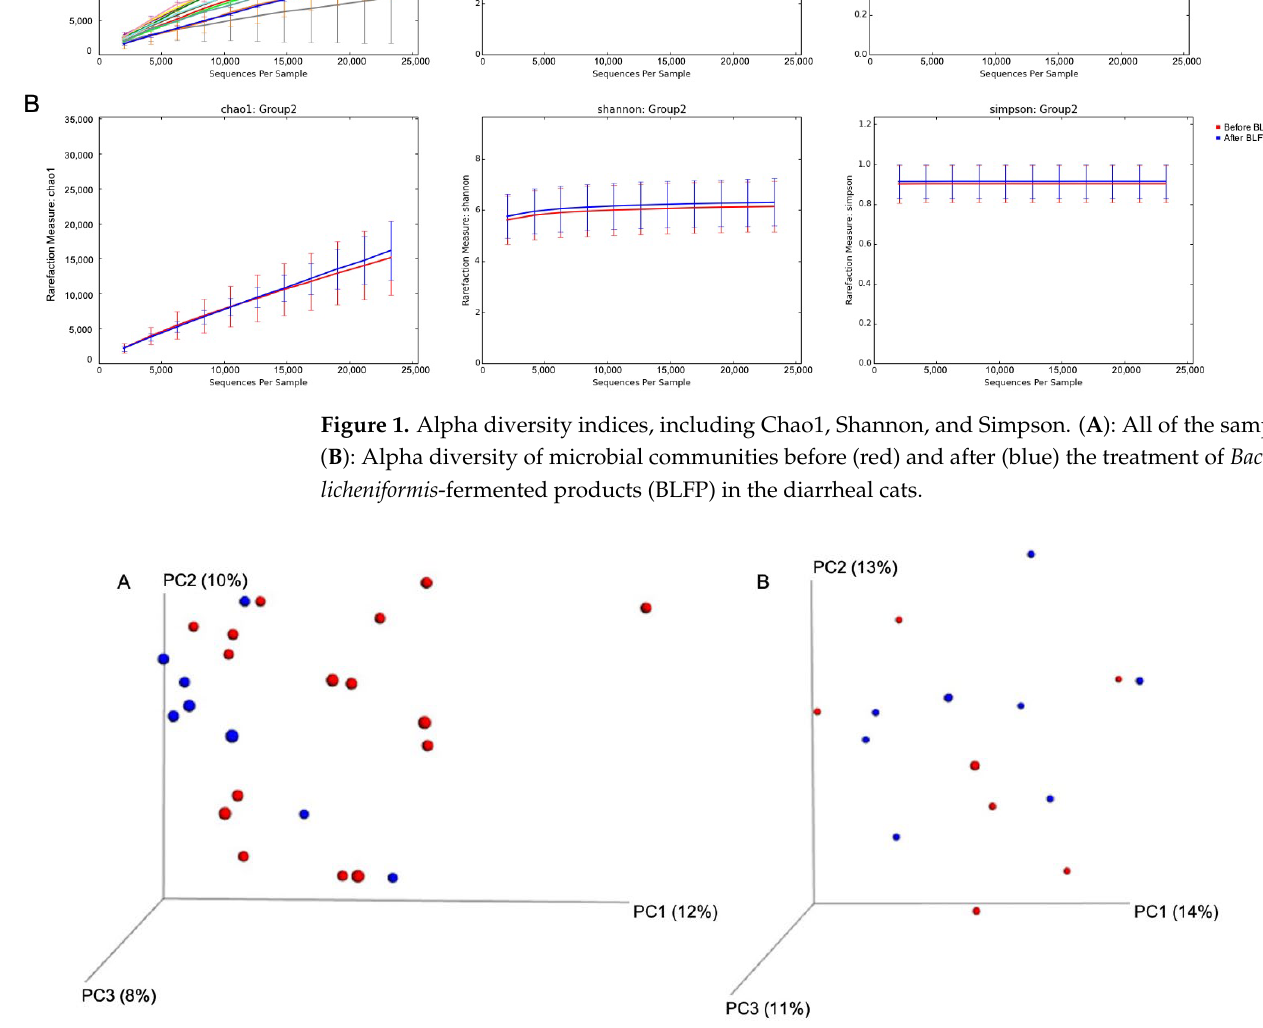
Figure 2. Beta diversity based on principal coordinate analysis (PCoA). ( A ): diarrheal cats (red dots) and control cats (blue dots). ( B ): diarrheal cats before (red dots) and after (blue dots) the treatment of Bacillus licheniformis -fermented products (BLFP).